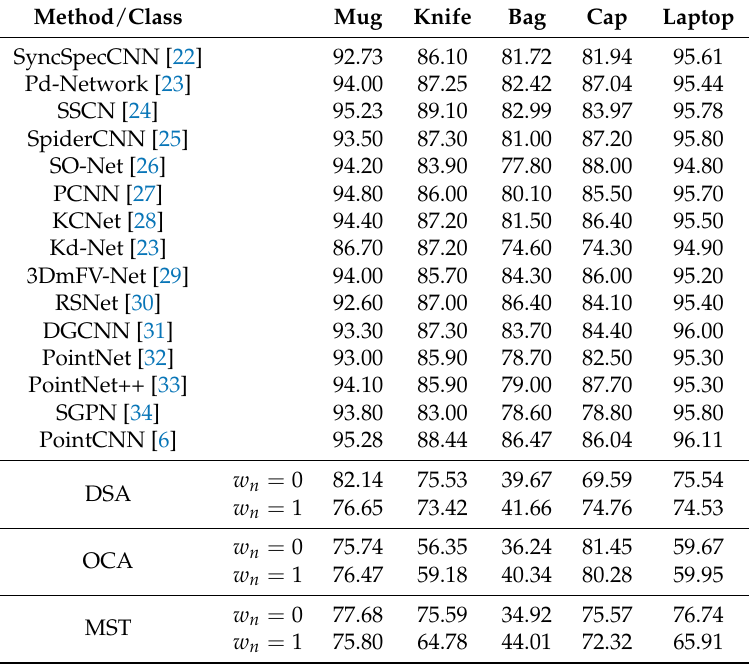
Table 3. Accuracy ( % ) comparison with the state-of-the-art methods. Method /